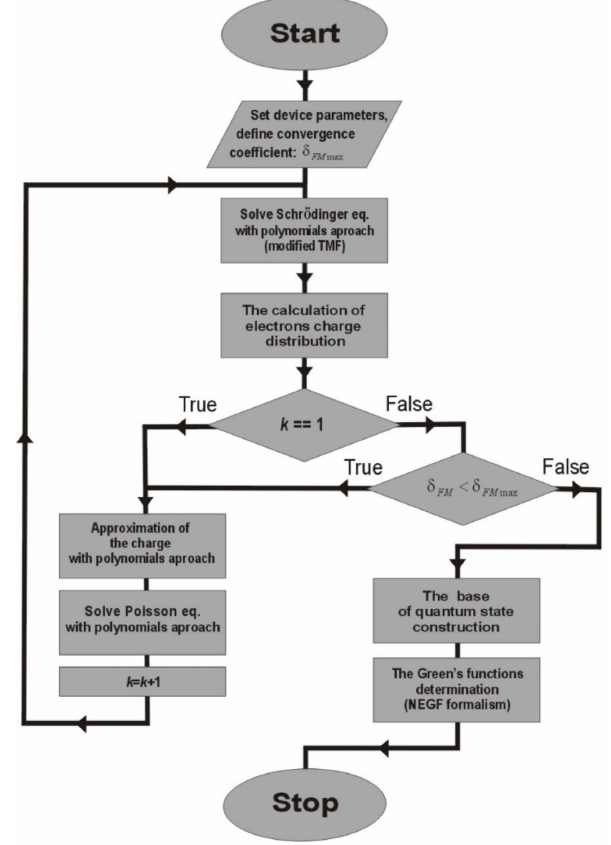
Figure 3. The main algorithm of self-consistent solving of Schrödinger and Poisson equations in the first type of superlattice structures for